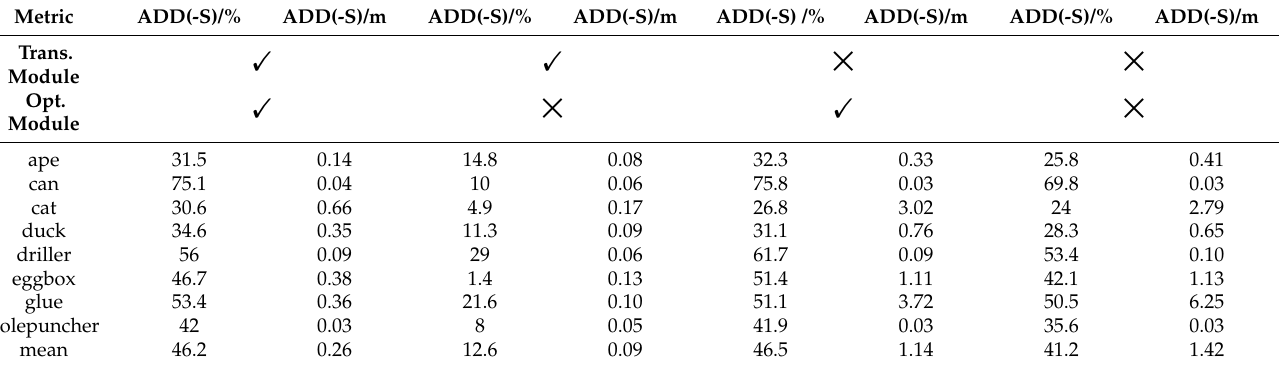
Table 1. Comparison results of module ablation